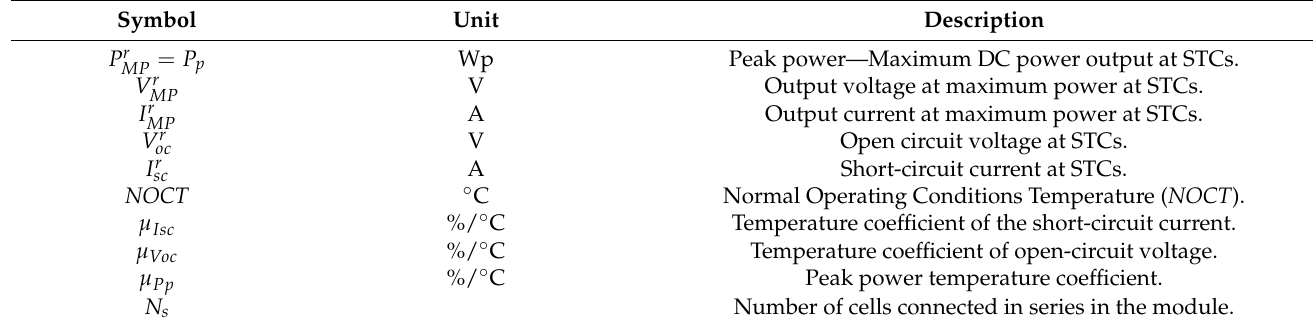
Table 1. Data commonly provided by manufacturers in PV modules